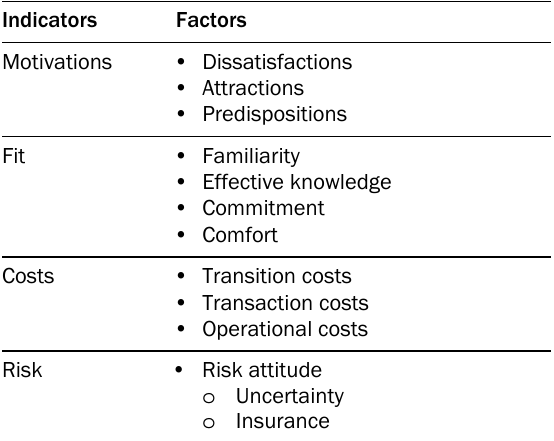
Table 1. Indicators in the Calculation of the Rela- tive Advantage of an